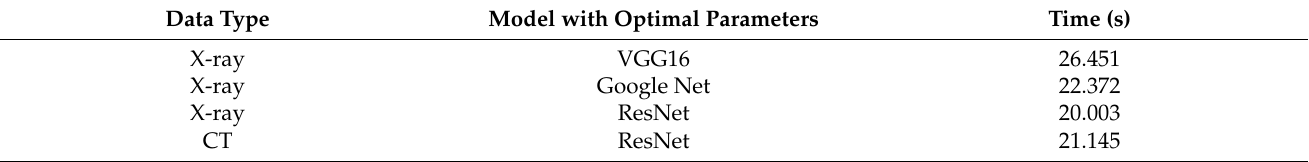
Table 13. Computational time for optimizing the hyperparameters for different